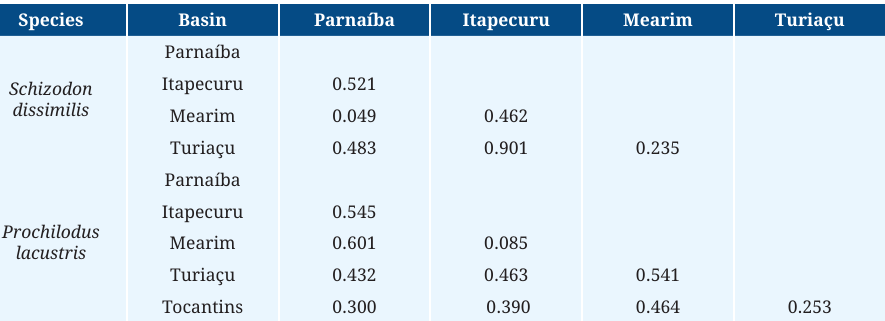
TABLE 5 | Pairwise Fst values for samples of Schizodon dissimilis and Prochilodus lacustris analyzed in this